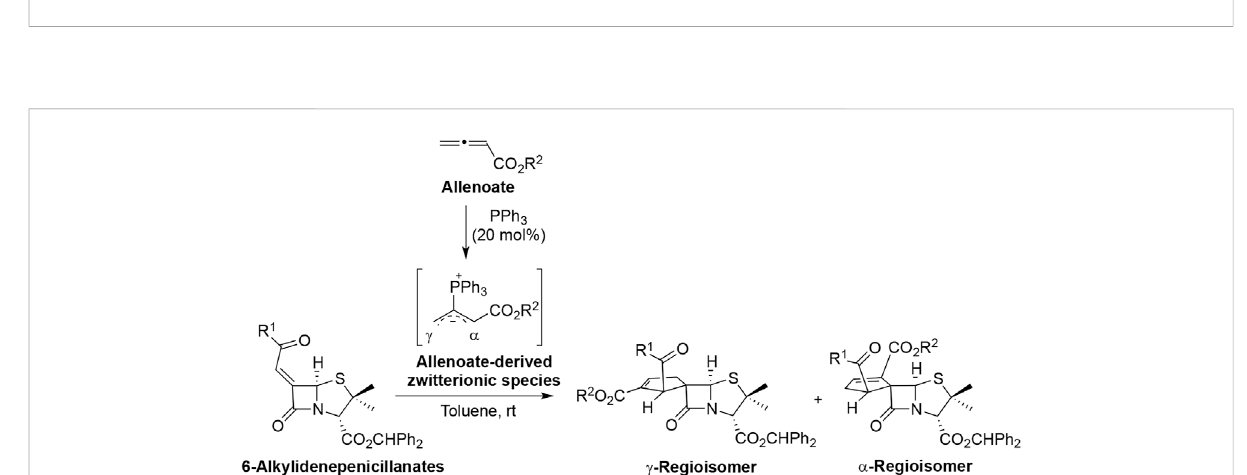
FIGURE 3 Designed structural modulation of lead molecule BSS-730A ( 3